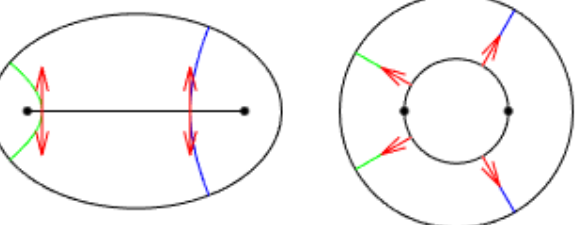
f ( r , θ ) represents, for fixed θ , the slope of f along the branch of hyperbola Figure 2. The derivative ∂ ∂ r identified by θ . Thus, if the derivative is evaluated in opposite orientations (red arrows) along the hyperbola, the sign must change.